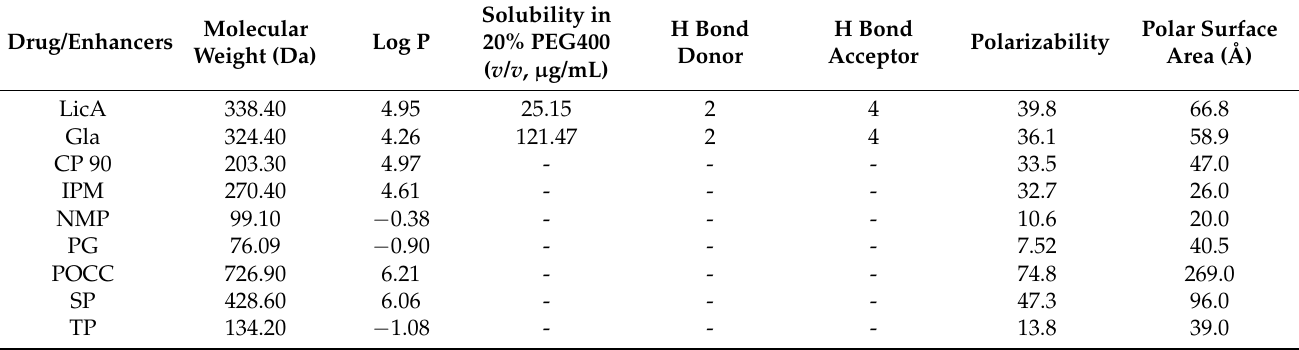
Figure 1. Schematic showing Gla and LicA release and permeation from CP hydrogel with enhancers. Table 1. The physicochemical parameters of different drugs and enhancers.